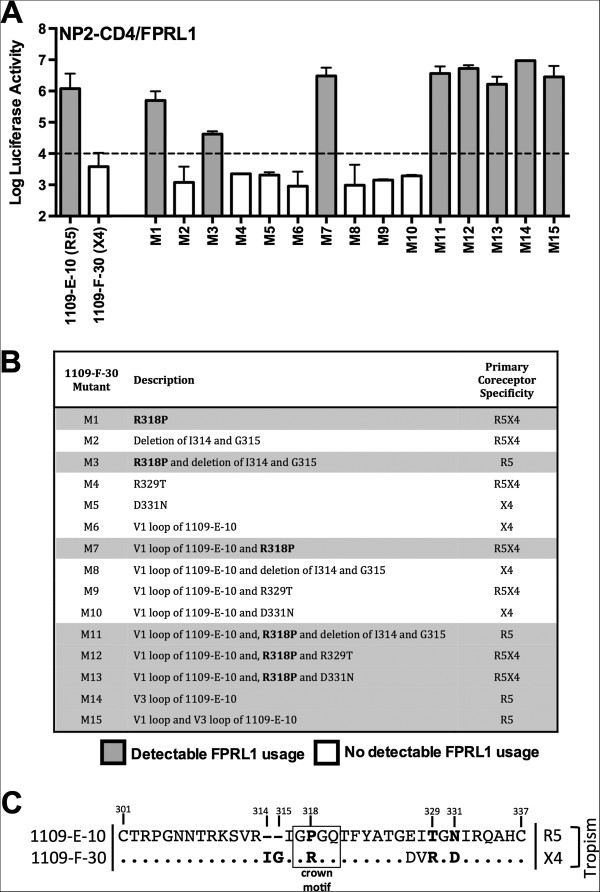
V3 loop alterations important for the association between CCR5 and FPRL usage. (A), luciferase reporter viruses pseudotyped with Env mutants (M1 through M15), or unmodified 1109-E-10 and 1109-F-30 Envs were used to infect NP2-CD4/FPRL1 cells, and the levels of HIV-1 entry were determined as described in the Methods. Open bars indicate Envs where no detectable FPRL1 usage was observed, and shaded bars indicate Envs with detectable FPRL1 usage. The dotted line indicates the limit of detection of coreceptor activity, as determined by infections with luciferase reporter virus pseudotyped with the non-functional ∆KS Env [44]. The results shown are a compilation of 3 independent experiments, each performed in triplicate. The data shown are means, and the error bars represent standard errors of the means. (B), summary of descriptions of the Env mutants. Shaded rows illustrate the Env mutants which had detectable FPRL1 usage. The R318P mutation, which was strongly associated with both CCR5 and FPRL1 usage, is highlighted in bold. The primary coreceptor specificity of the Env mutants (ie., whether they exhibit an R5, R5X4 or X4 phenotype) was determined previously [8]. (C), comparisons of the V3 loop region between the R5 1109-E-10 and X4 1109-F-30 Envs. Shown in bold are the amino acids tested by mutagenesis for modulation of FPRL1 usage, and boxed is the V3 crown motif shown to principally modulate FPRL1 usage.